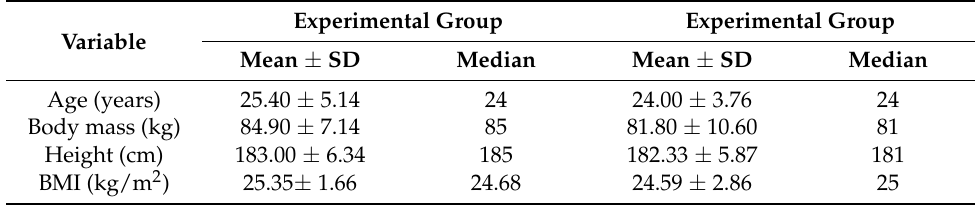
Table 1. Basic characteristics of participants ( n = 30).